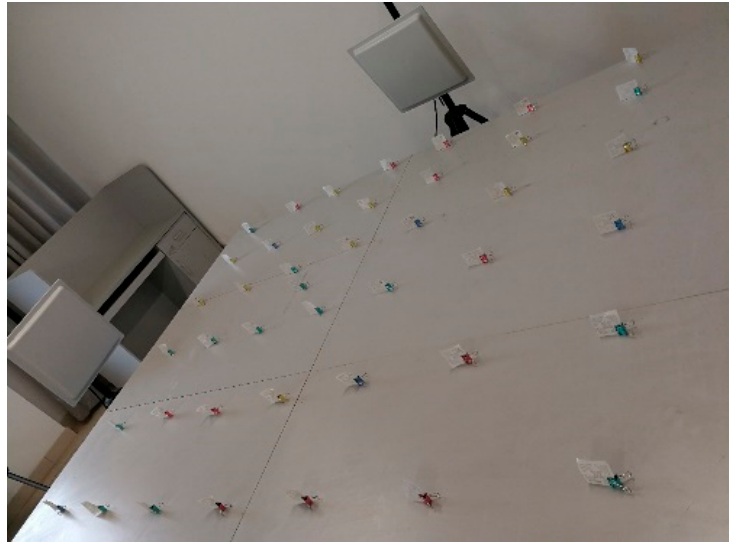
Figure 3. Part of the experimental environment.